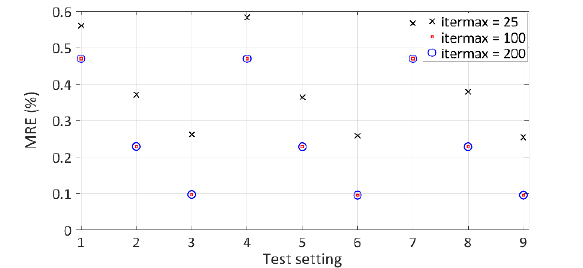
Figure 5: MRE of the adapted input variable with different test set-